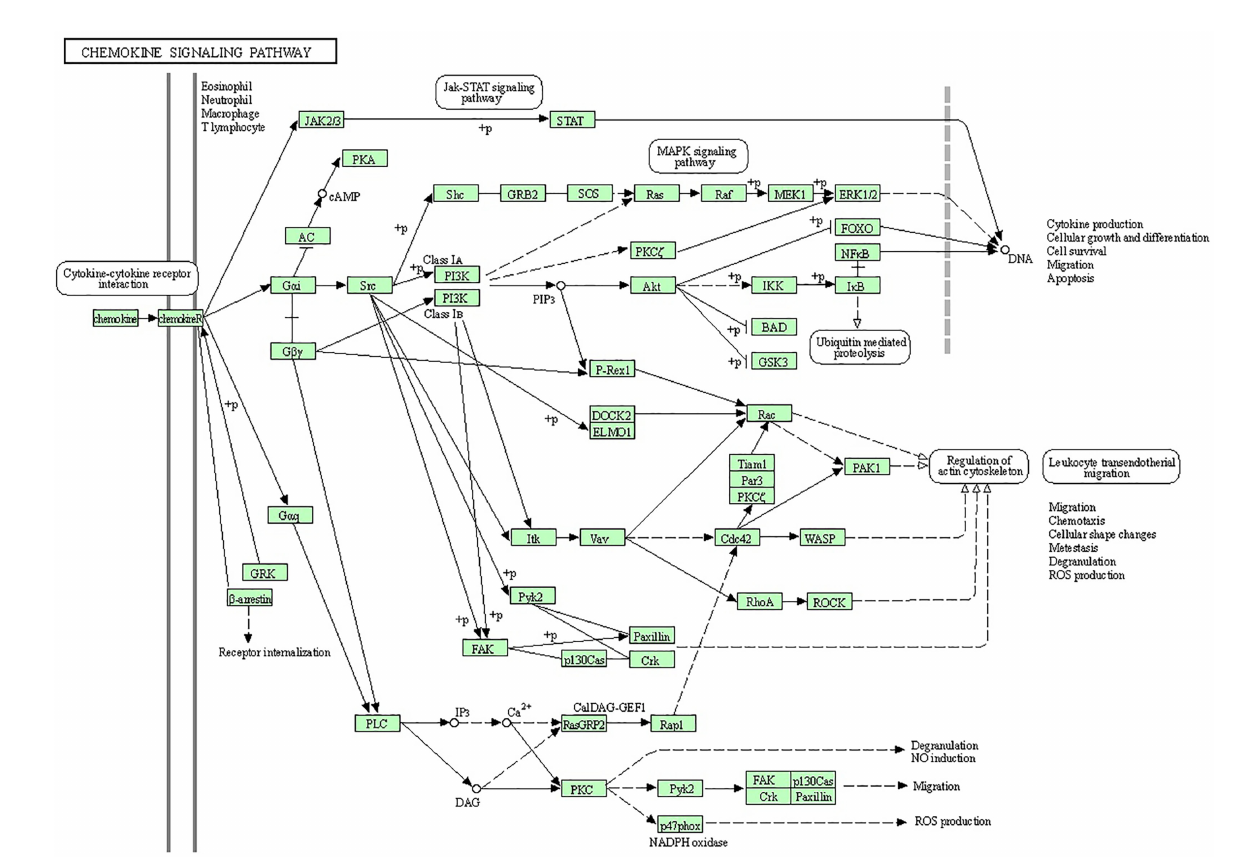
FIGURE 2 In fl ammatory immune response requires the recruitment of leukocytes to the site of in fl ammation upon foreign insult. Chemokines are small chemoattractant peptides that provide directional cues for cell traf fi cking and are therefore vital for protective host response. In addition, chemokines regulate a plethora of biological processes of hematopoietic cells, leading to cellular activation, differentiation, and survival. The chemokine signal is transduced by chemokine receptors (G-protein coupled receptors) expressed on the immune cells. After receptor activation, the alpha- and beta- gamma-subunits of G protein dissociate to activate diverse downstream pathways, resulting in cellular polarization and actin reorganization. Various members of small GTPases are involved in this process. The induction of nitric oxide and the production of reactive oxygen species are also regulated by the chemokine signal via calcium mobilization and diacylglycerol